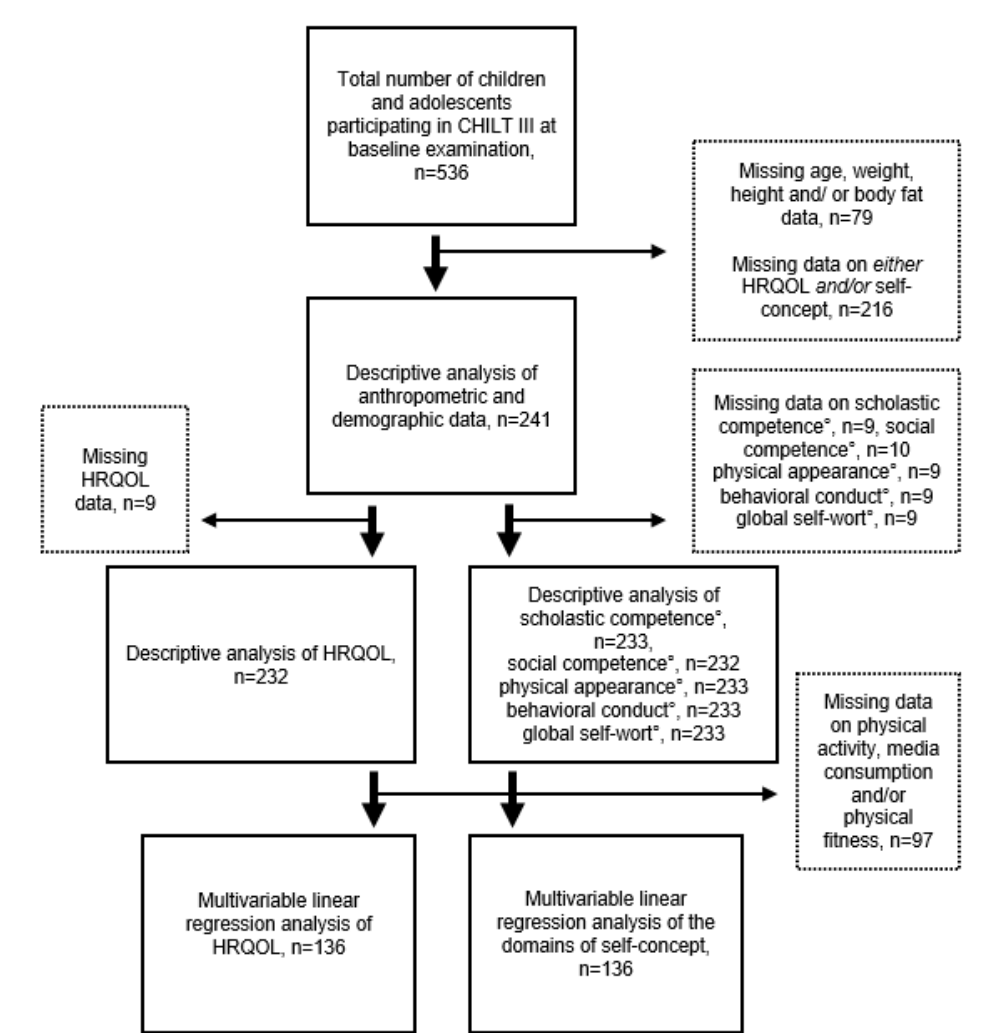
Figure 1. Flow Chart of Number of Participants in the Study; HRQOL, Health-Related Quality of Life; CHILT, Children’s Health InterventionaL Trial; ◦ subdomains of self-concept; vertical arrows, stepwise procedure of the study; horizontal arrows, stepwise exclusion criteria